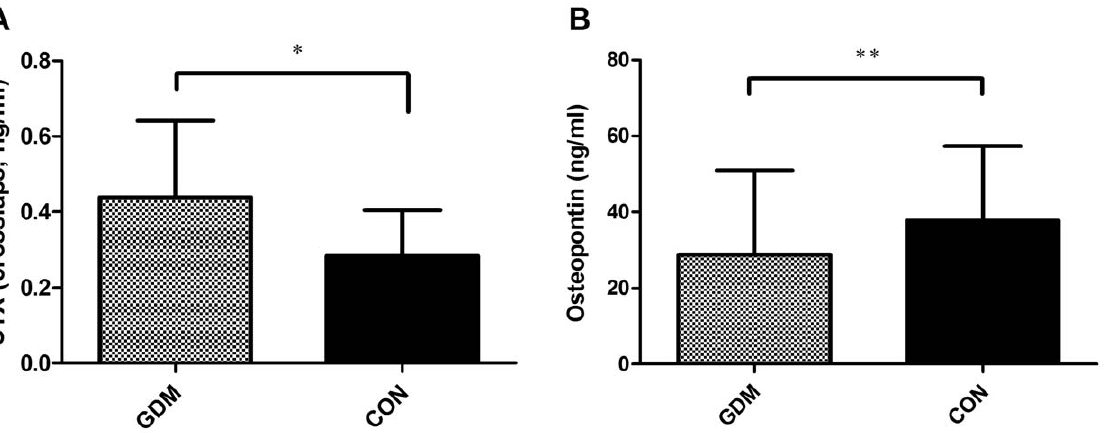
Figure 1. Plasma concentrations of CTX (A) and osteopontin (B) in women with gestational diabetes (GDM) and women with normal glucose tolerance during pregnancy (CON, black boxes) between 24–28th gestational weeks. *p , 0001, **p=0.04.